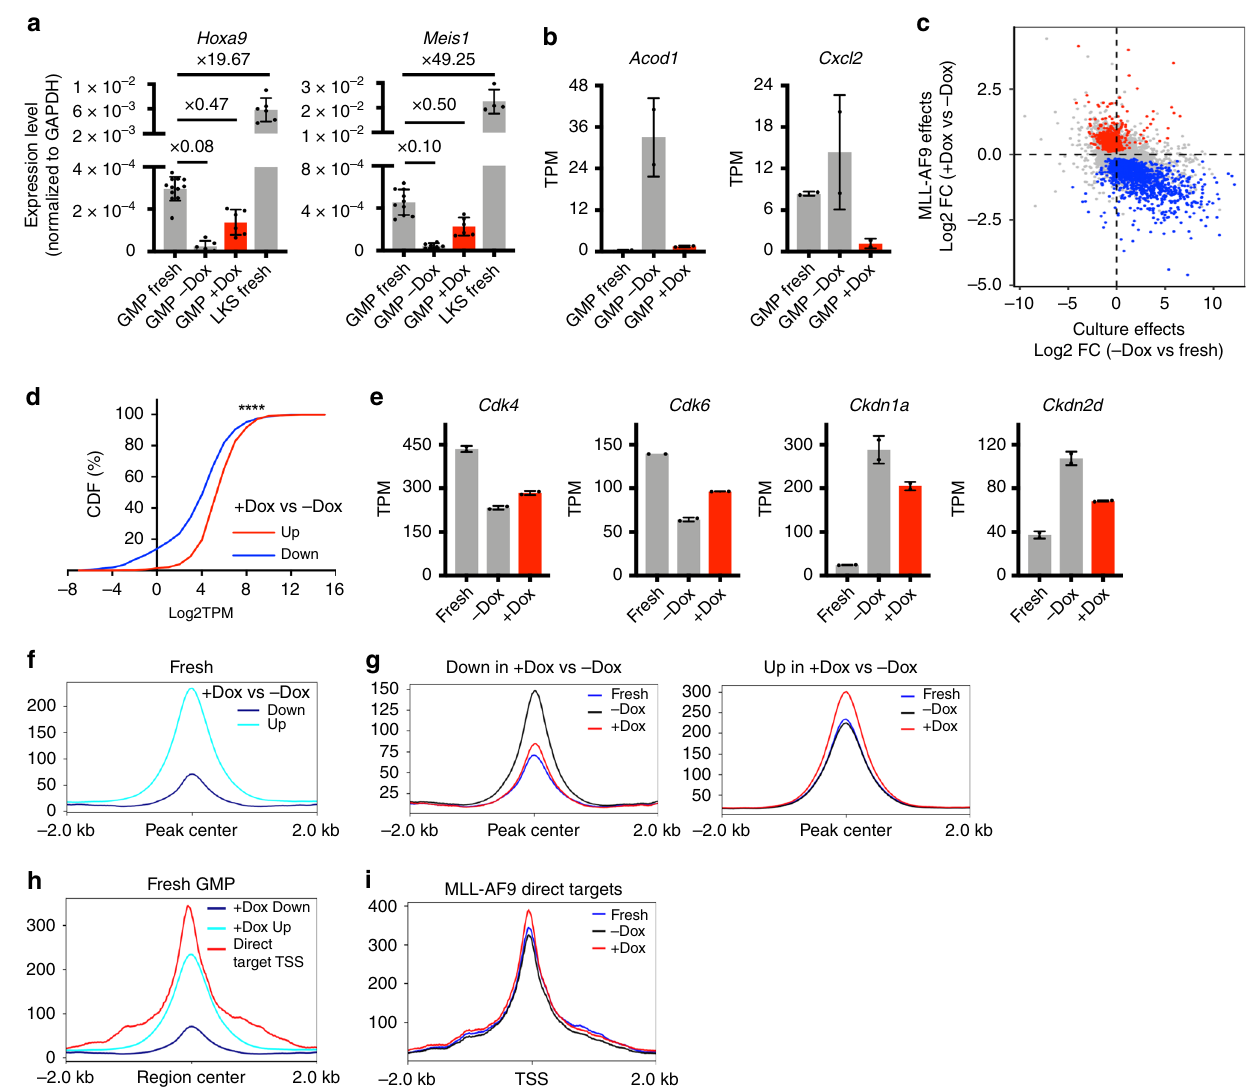
Fig. 3 MLL-AF9 expression sustains the already existing gene expression program in GMPs. a The expression levels of Hoxa9 and Meis1 in LKS, fresh GMPs, and GMPs cultured + / − Dox. The fold of change in each gene expression relative to the levels in fresh GMPs are shown. p < 0.01 for all pair-wise comparisons as calculated by two-sided unpaired t -test. b Expression levels of Acod1 and Cxcl2 in fresh GMPs and GMPs cultured + / – Dox. c Scatter plot showing culture-induced gene expression changes ( − Dox vs fresh GMPs) vs MLL-AF9-induced changes ( + Dox vs − Dox GMPs). Blue dots represent the oncogene downregulated DEGs; red dots represent the oncogene upregulated DEGs. d Cumulative distribution function plot showing the expression levels of DEGs in fresh GMPs. DEGs are derived by comparing + / − Dox GMPs. Red line: genes upregulated in + Dox GMPs ( n = 1258); blue line: genes downregulated in + Dox GMPs ( n = 1715). TPM: transcript per million. p < 0.0001 from Kolmogorov – Smirnov test. e Representative expression levels of up/downregulated cell cycle genes. f Meta plot summarizing the intensities of up/down ATAC-seq peaks in fresh GMPs. The up and down ATAC-seq peaks are de fi ned by comparing + Dox GMPs vs − Dox GMPs. g Dox inductions (red line) prevented the opening of chromatin regions during GMP culture (left, blue vs black lines), and promoted the further opening of chromatin regions that are already accessible in fresh GMPs (right, blue line). The ATAC- seq peaks (down or up) are de fi ned by comparing + Dox GMPs vs − Dox GMPs. h The direct targets of MLL-AF9 (red line, de fi ned by MLL-AF9 ChIP- Seq 24 ) were highly accessible in fresh GMPs, beyond those more accessible regions caused by Dox induction (cyan line). i 24 h of Dox induction (red line) promoted further opening of the genomic regions directly bound by MLL-AF9 (de fi ned by MLL-AF9 CHIP-Seq 24 ), which display signi fi cant accessibility in fresh GMPs (blue line). Results are presented as